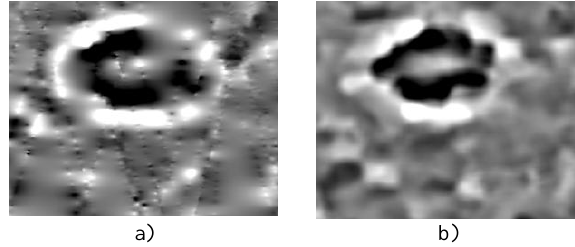
Figure 1. The results of RTP’s calculation by different DEMs: a) a small fragment of DEM obtained by MLA data (with resolution 665 m/pixel), interpolation of individual tracks causes artifacts that cross the crater; b) a fragment of the